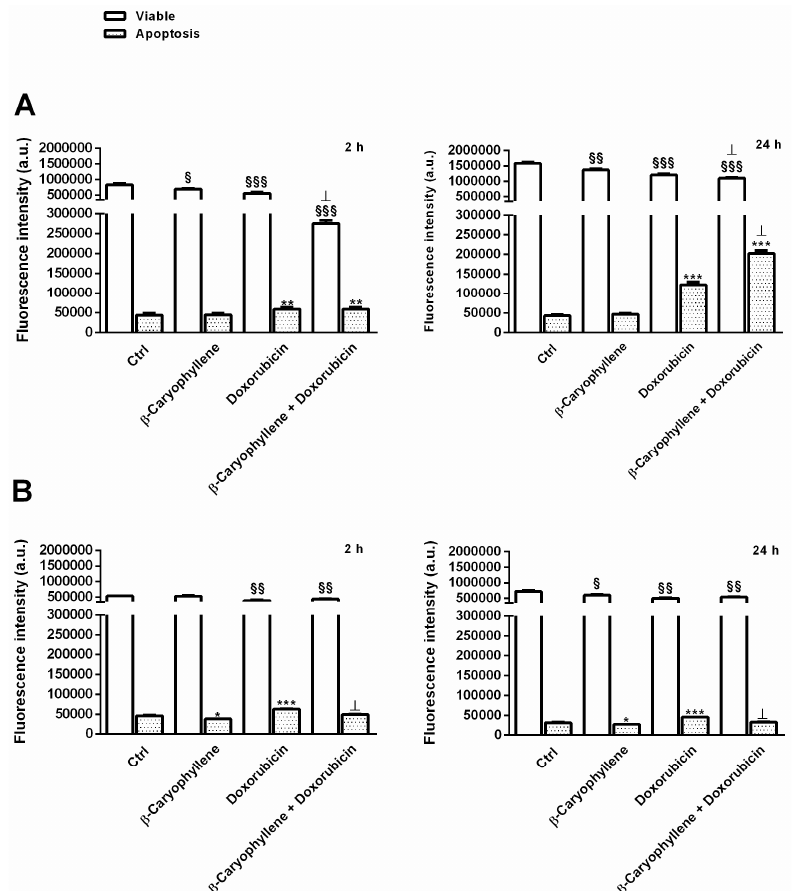
Figure 10. Bar graphs (data expressed as mean ± standard error at least two independent replicates) of apoptosis induced by the natural sesquiterpene β -caryophyllene (50 µM), doxorubicin (20 µM) and their combination compared the control in Mz-ChA-1 cholangiocarcinoma cells ( A ) and H69 noncancerous cholangiocytes ( B ). The cells were treated for 2 h and 24 h, then the pellets were harvested and stained with Annexin-V-Cy3 and carboxyfluorescein diacetate (CFDA) for the cytofluorimetric analysis of apoptotic and viable cells (FL-2 for annexin and FL-1 for CF; BD AccuriTM C6 flow cytometer). Cells undergoing apoptosis were sorted by their typical forward- and side scatter (FSC-SSC) pattern, i.e., increased SSC and decreased FSC, respect to the viable cells. § p < 0.05, §§ p < 0.01 and §§§ p < 0.001 (one-way ANOVA followed by Dunnett’s multiple comparison post-test) denote a significant di ff erence in the viable cells of the treatments compared the control. * p < 0.05, ** p < 0.01 and *** p < 0.001 (one-way ANOVA followed by Dunnett’s multiple comparison post-test) denote a significant di ff erence in the apoptotic cells of the treatments compared the control. ⊥ p < 0.01 (t-Student test) denotes a significant di ff erence with respect to